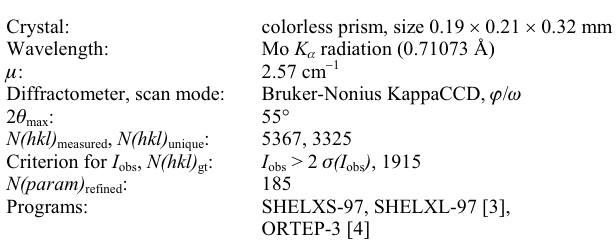
Table 1. Data collection and handling.